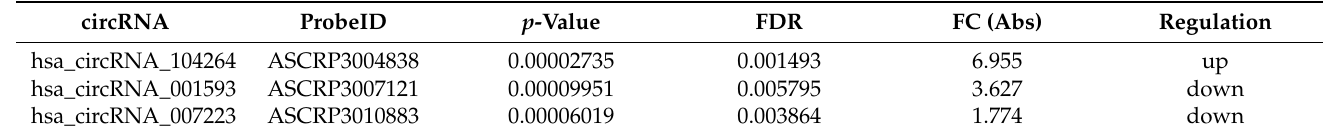
Table 3. Snapshot of differentially expressed circRNA table.